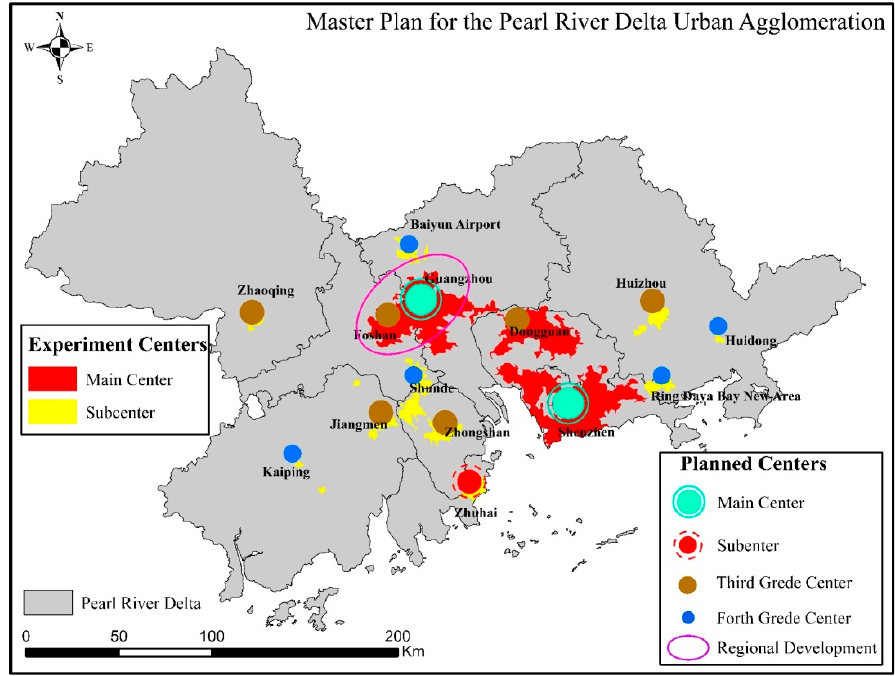
Figure 14. Discussion and comparison of experimental results and overall planning.